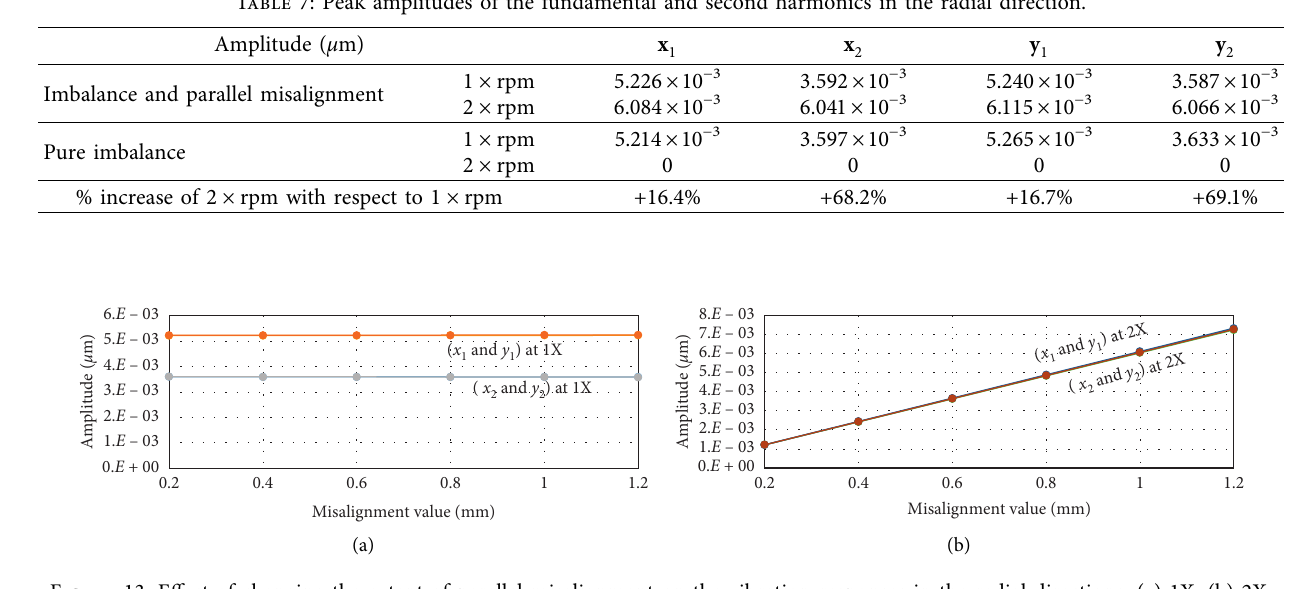
Figure 13: Effect of changing the extent of parallel misalignment on the vibration responses in the radial directions. (a) 1X; (b)